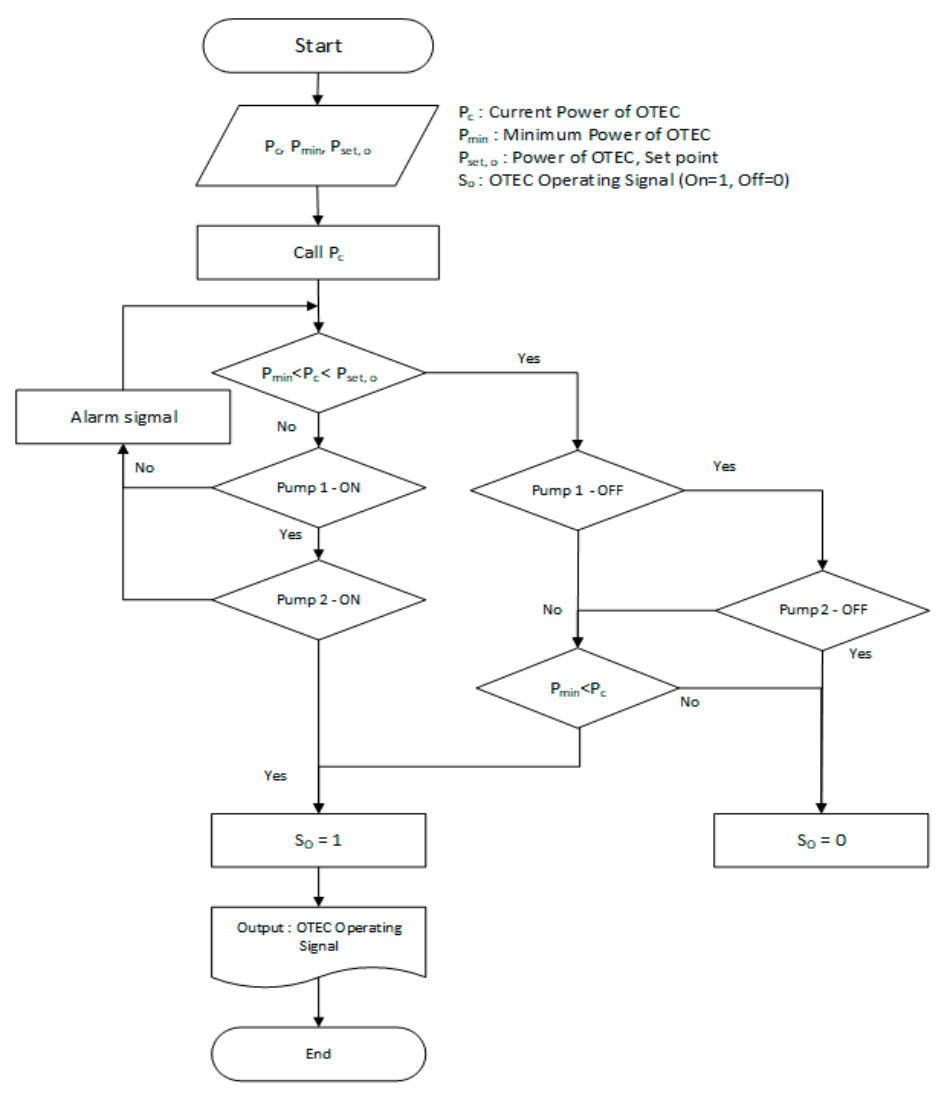
Figure 8. Control logic of the refrigerant pump.